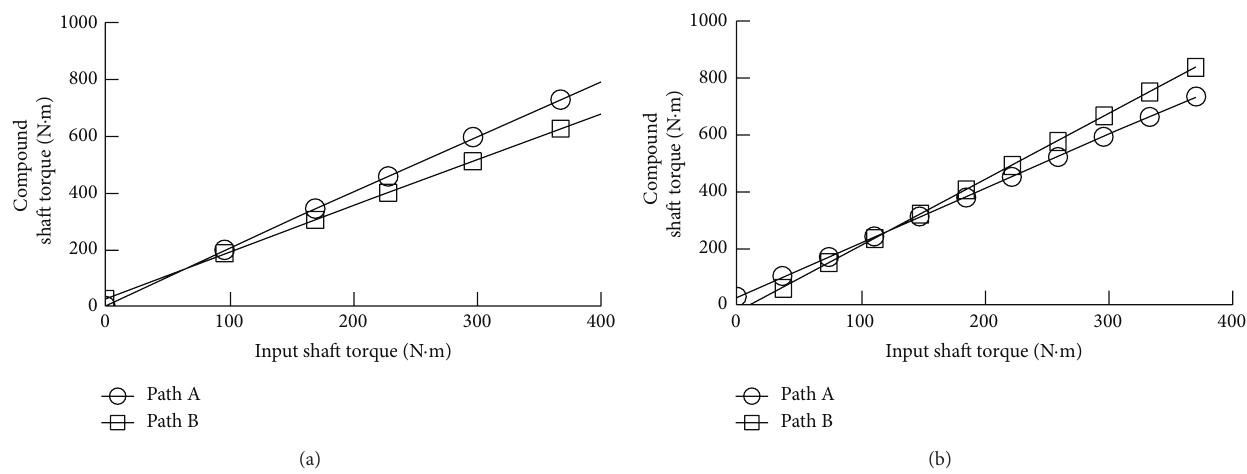
Figure 20: Typical examples of date and curve fits of compound shaft torques as a function of input shaft torques. (a) Experimental example. (b) Numerical